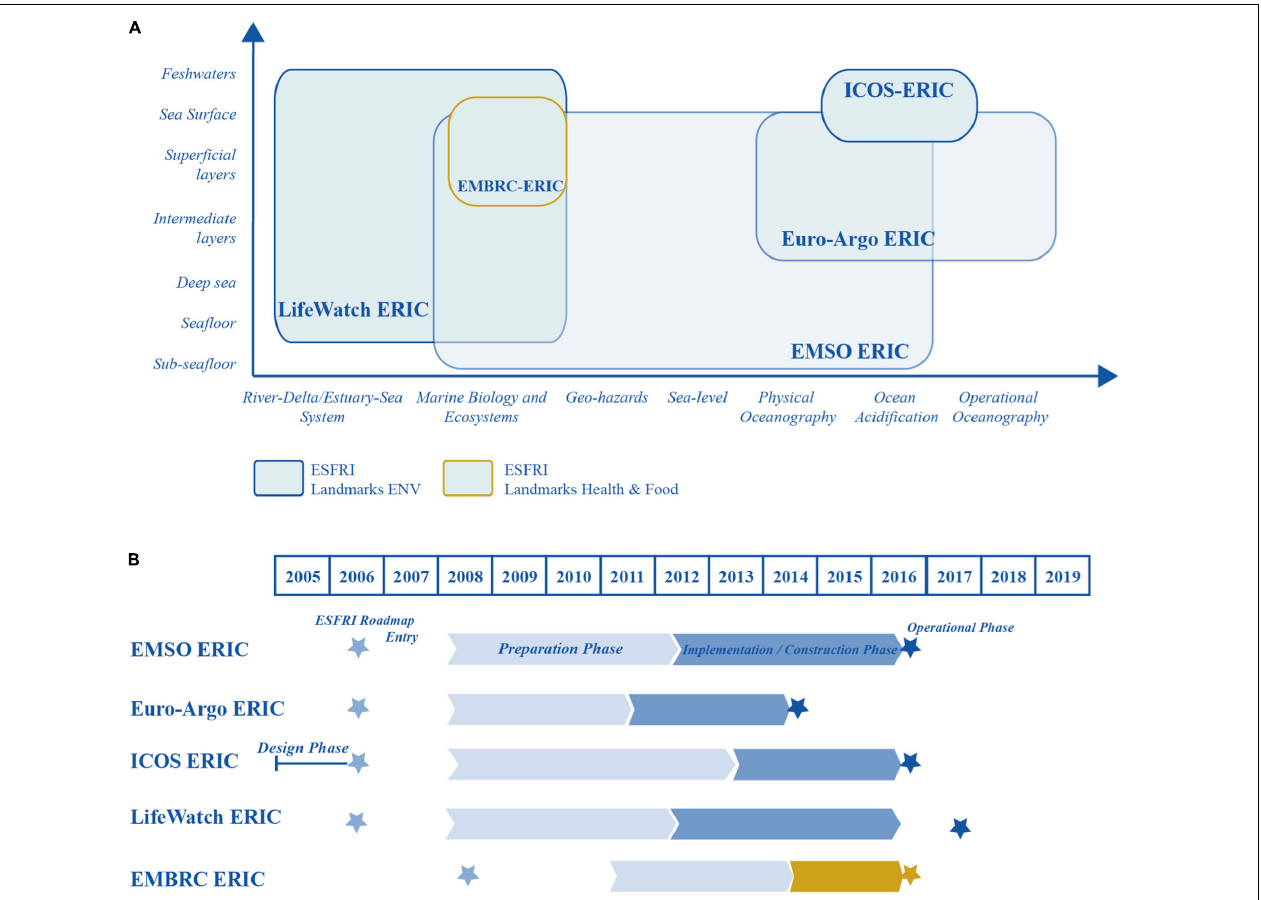
FIGURE 1 | (A) Simplified diagram of the observation capabilities of five pan-European RIs with respect to their hydrosphere components (Y axis) and environmental processes (X axis); (B) Timeline of the five RIs since their entry in the ESFRI Roadmap [redrawn from European Strategy Forum on Research Infrastructures [ESFRI]